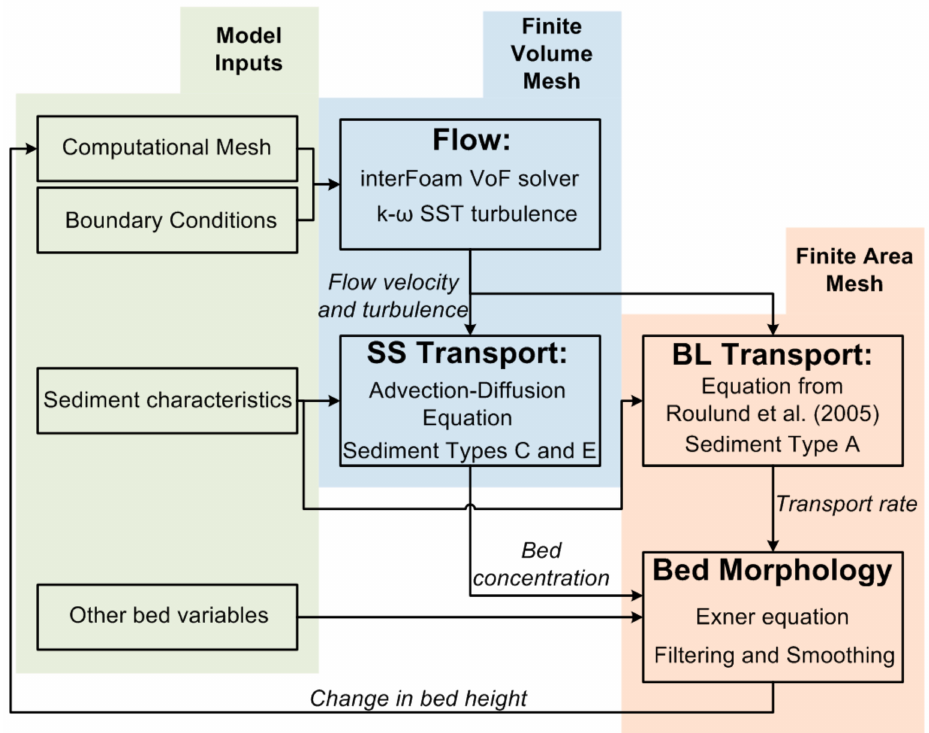
Figure 2. A flowchart representing the overall framework of the SSF solver and the interactions between the major components, i.e., flow, Suspended Sediment (SS) transport, Bedload (BL) transport, and bed morphology. The green shading indicates initial user inputs, the blue shading indicates processes that occur within the Finite Volume mesh, and the orange shading represents processes in the Finite Area deposited bed